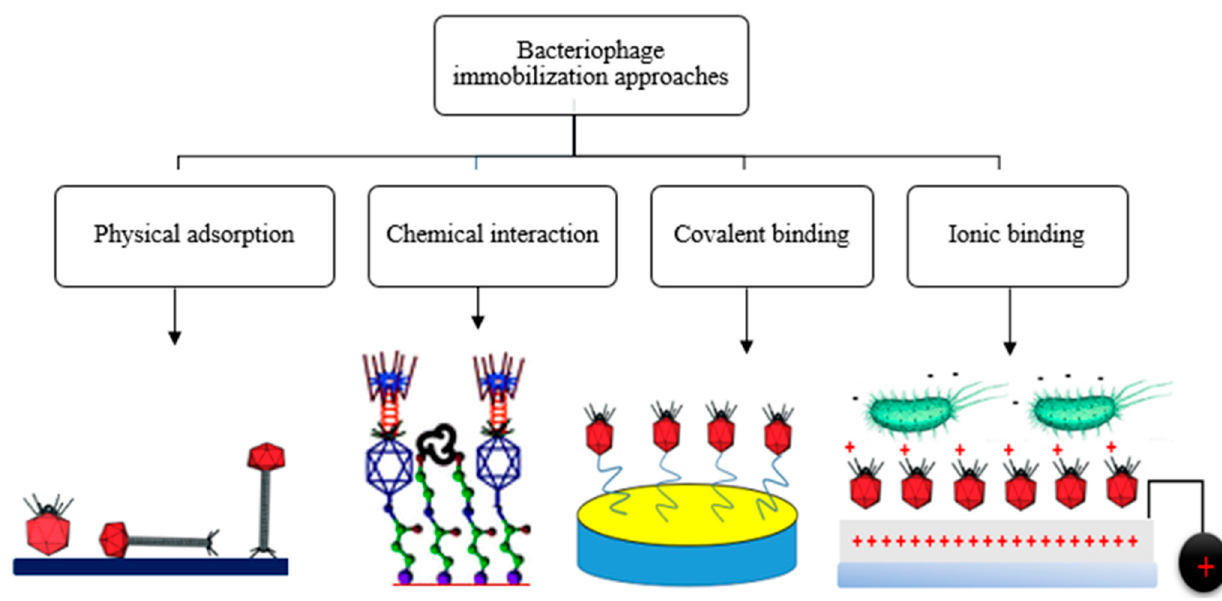
Figure 3. Strategies used for immobilization of phages on biosensor platforms.